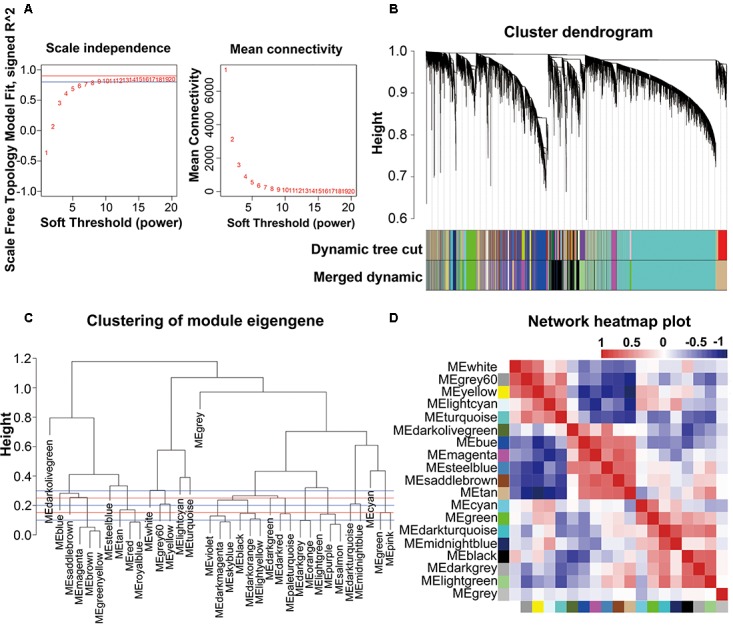
WGCNA network and module detection. (A) Selection of the soft-thresholding powers. The left panel showed the scale-free fit index versus soft-thresholding power. The right panel displayed the mean connectivity versus soft-thresholding power. Power 8 was chose, for which the fit index curve flattens out upon reaching a high value (>0.9). (B) Cluster dendrogram and module assignment for modules from WGCNA. Genes were clustered based on a dissimilarity measure (1-TOM). The branches correspond to modules of highly interconnected groups of genes. Colors in the horizontal bar represent the modules. 35 modules with 24,455 transcripts were detected with WGCNA. (C,D) Meta-module identification and module-module relationship. The module network dendrogram was constructed by clustering module eigengene distances. The horizontal line (blue and red line) represents the threshold (0.2) used for defining the meta-modules. Thus, 19 distinct gene modules were identified. In the heatmap of module-module relationship, the progressively more saturated blue and red colors indicated the high co-expression interconnectedness.